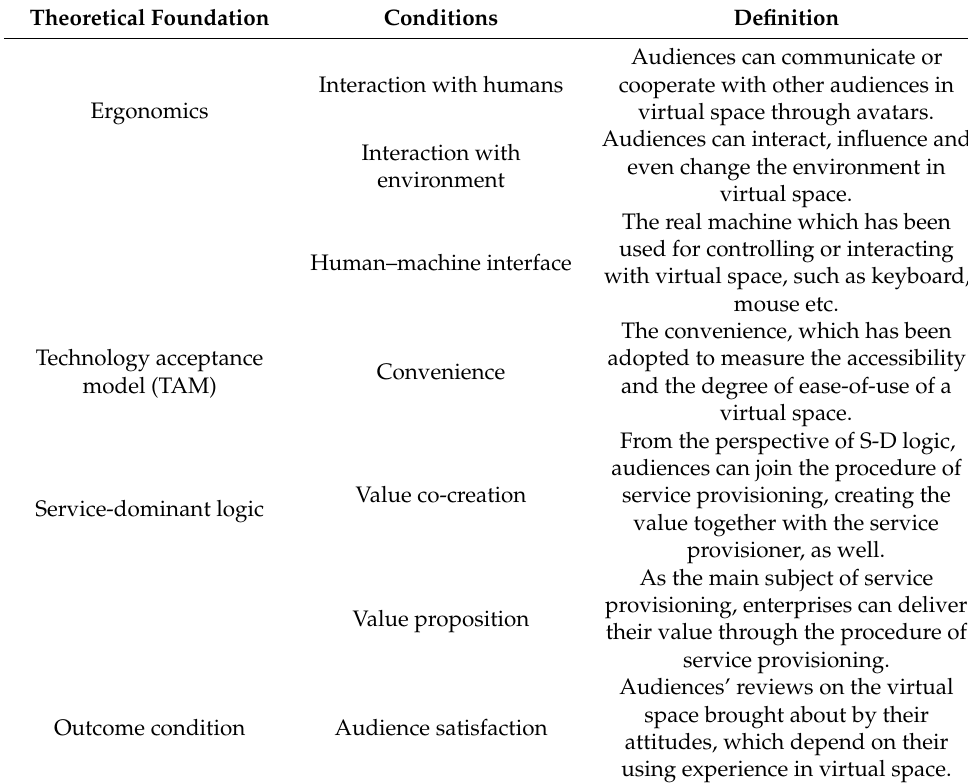
Table 1. An introduction to